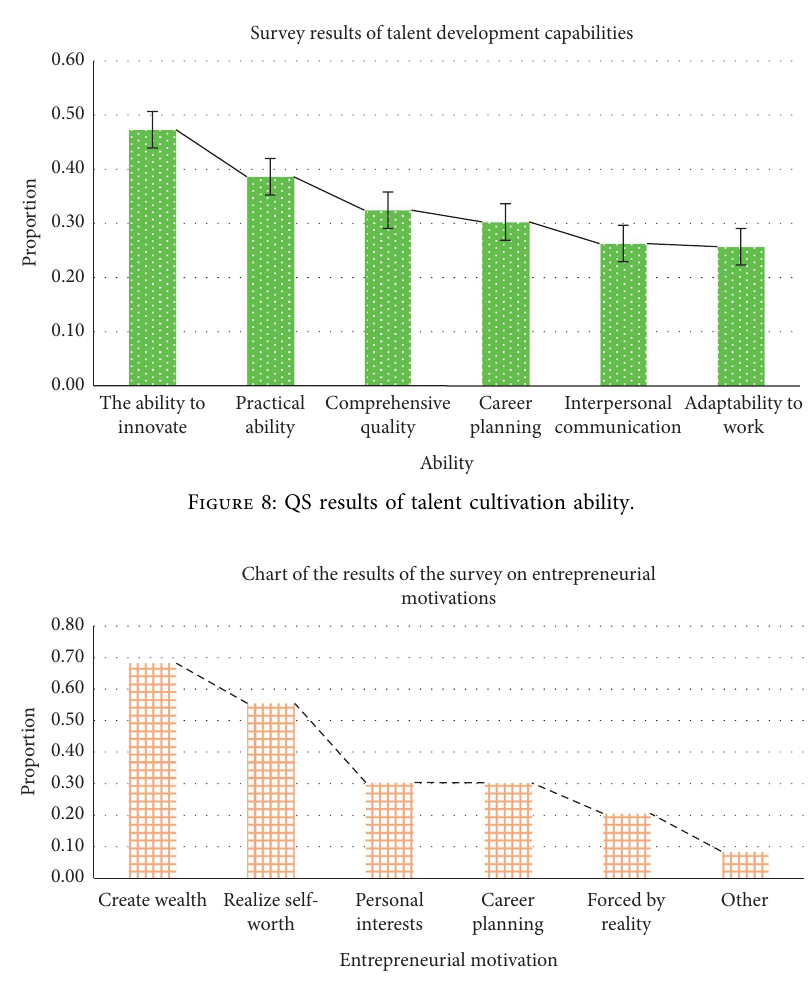
Figure 9: QS results of entrepreneurial motivation.